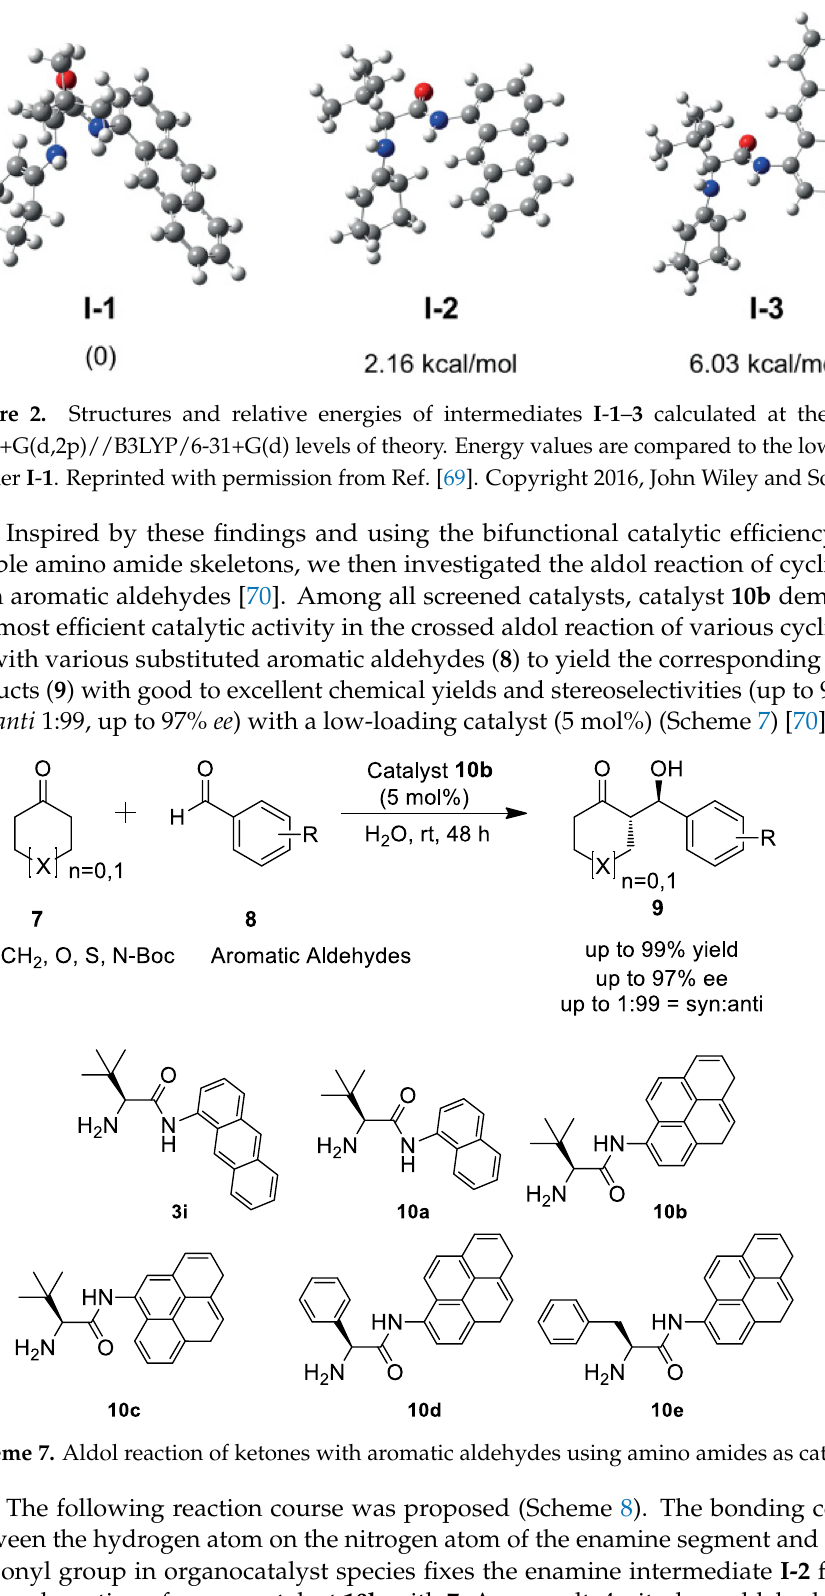
Scheme 7. Aldol reaction of ketones with aromatic aldehydes using amino amides as